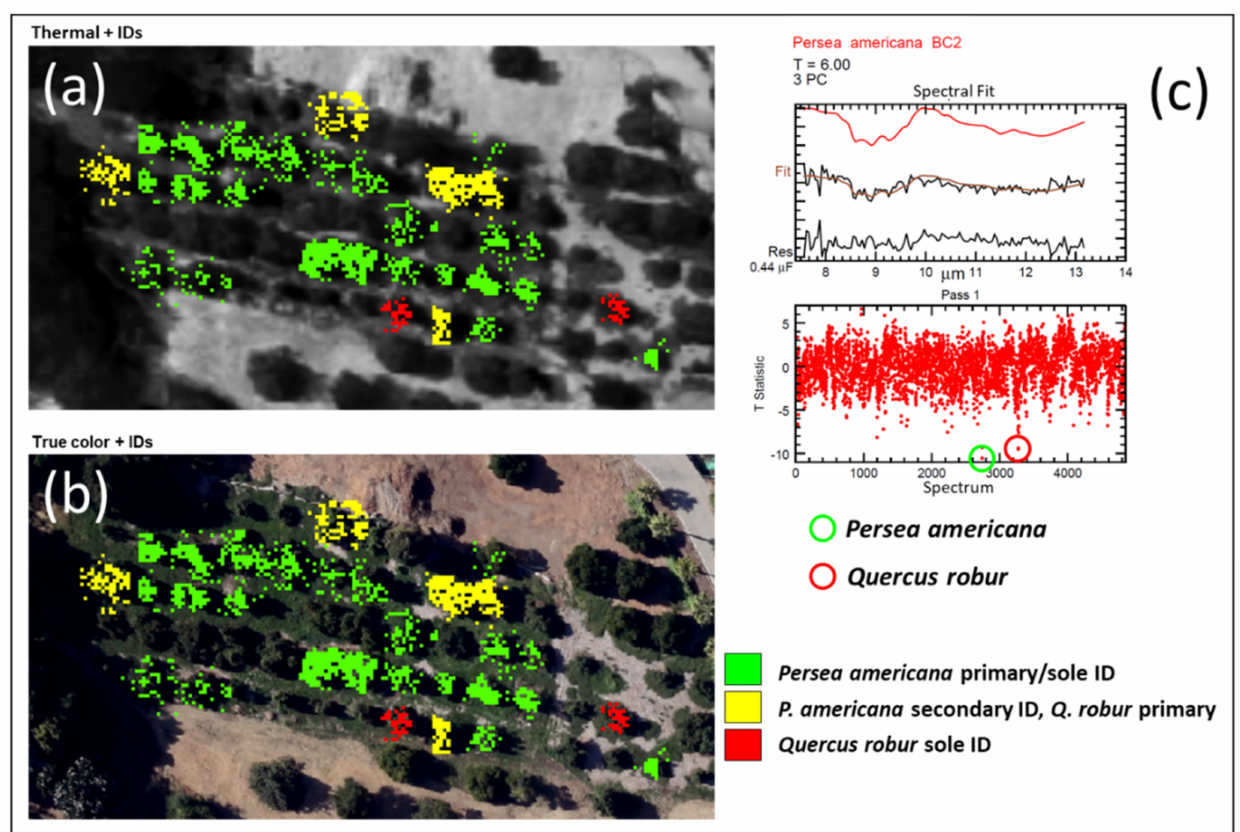
Figure 12. Huntington Gardens avocado orchard: IDs overlaid on ( a ) thermal scene image, ( b ) true-color scene image, ( c ) spectral analysis results showing the proximity of the Quercus robur spectrum to that of Persea americana .